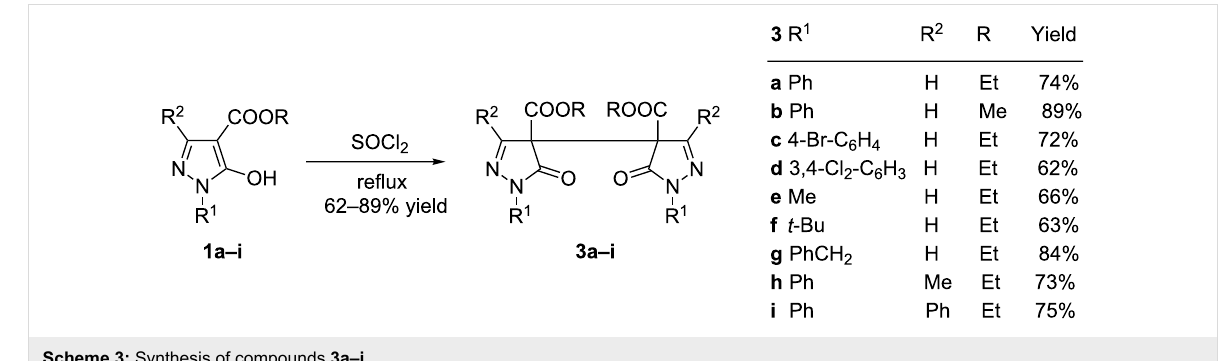
Scheme 3: Synthesis of compounds 3a–i .